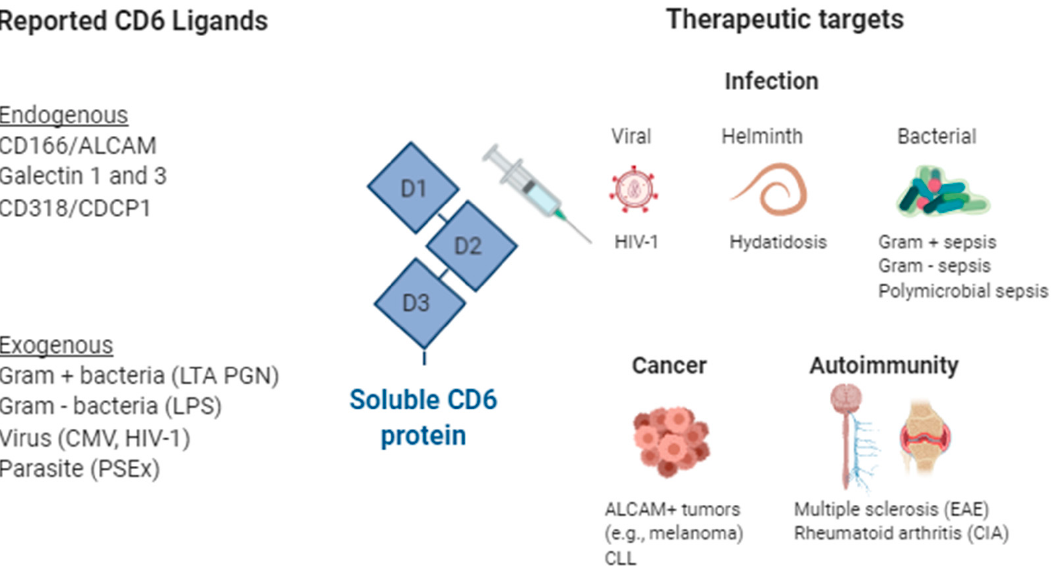
Figure 2. Soluble CD6 decoy receptor-based therapeutic strategies in infection, immunomodulation, autoimmunity, and cancer. Reported CD6 ligands and their therapeutic targets. ALCAM, Activated Leukocyte Cell Adhesion Molecule; CD, cluster of differentiation; CDCP1, CUB domain-containing protein 1; CIA, Collagen Induced Arthritis; CLL, chronic lymphocytic leukemia; CMV, cytomegalovirus; HIV,humanimmunodeficiencyvirus; LTA,Lipoteichoicacid; LPS,lipopolysaccharide; PGN,Peptidoglycan; Created with